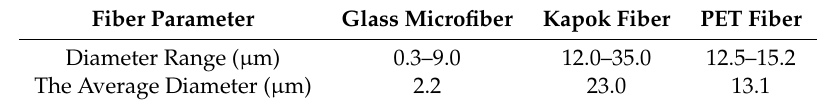
Figure 1. The dual-layer structure of filter media containing kapok fibers. Table 1. The diameter of different fibers.